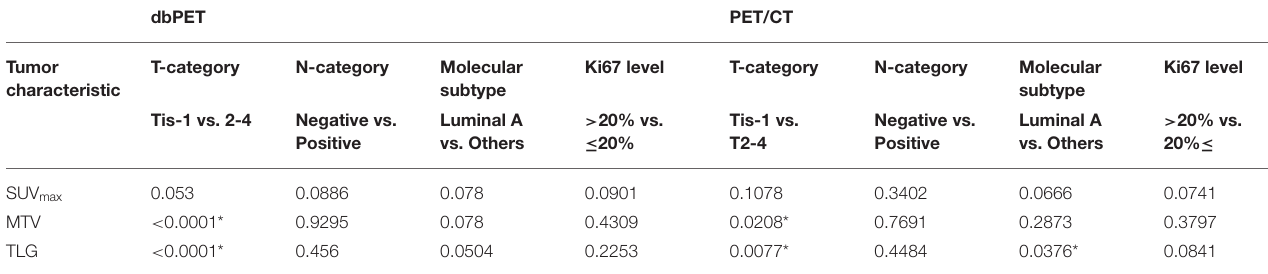
TABLE 4 | Associations ( p-value ) between conventional PET parameters and tumor characteristics. dbPET